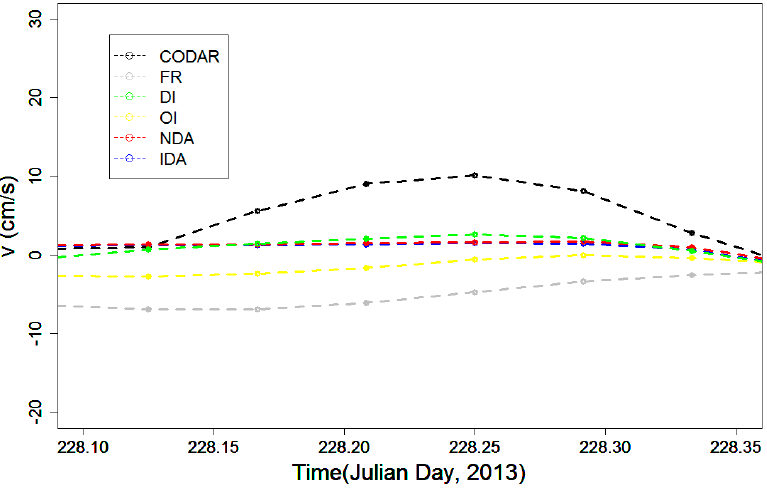
Figure 8. Time series of surface north–south velocity component (v) during forecasting period.